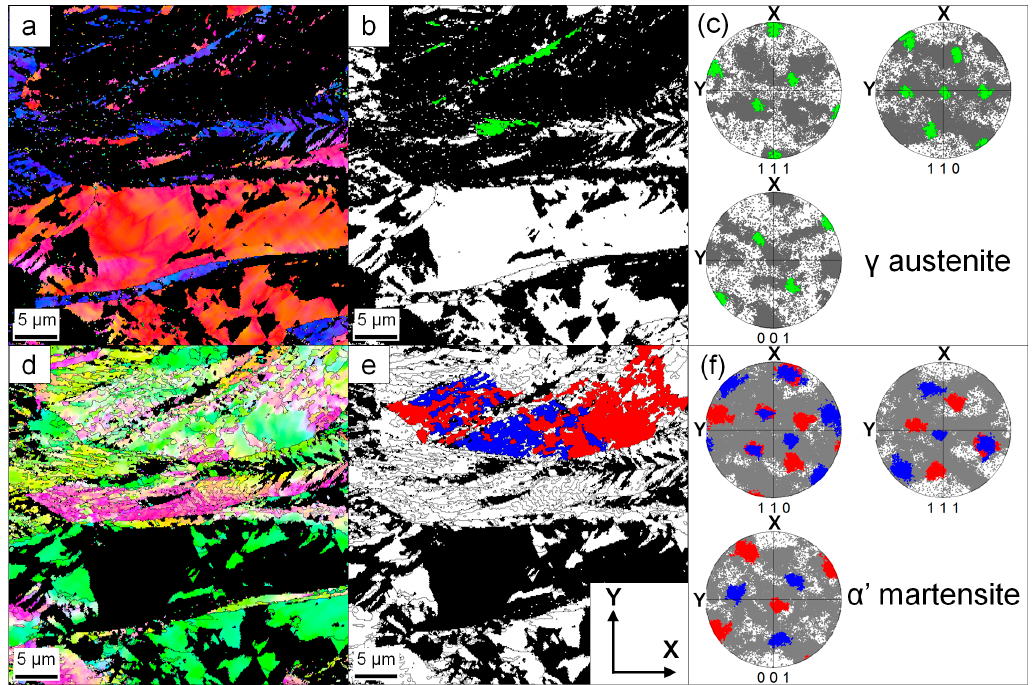
Figure 7. Phase partition maps and corresponding discrete pole figures of the deformed sample obtained by EBSD measurement up to a true strain of 0.42. ( a , d ) Inverted pole figures (IPF) (X) maps, ( b , e ) colors highlighted in the blank maps, and ( d , f ) highlighted pole figures of the ( a – c ) γ austenite and ( d – f ) α ’ martensite measured at a true strain of 0.42. Note that the tensile axis, X, is horizontal in the maps, but vertical in the pole figures.